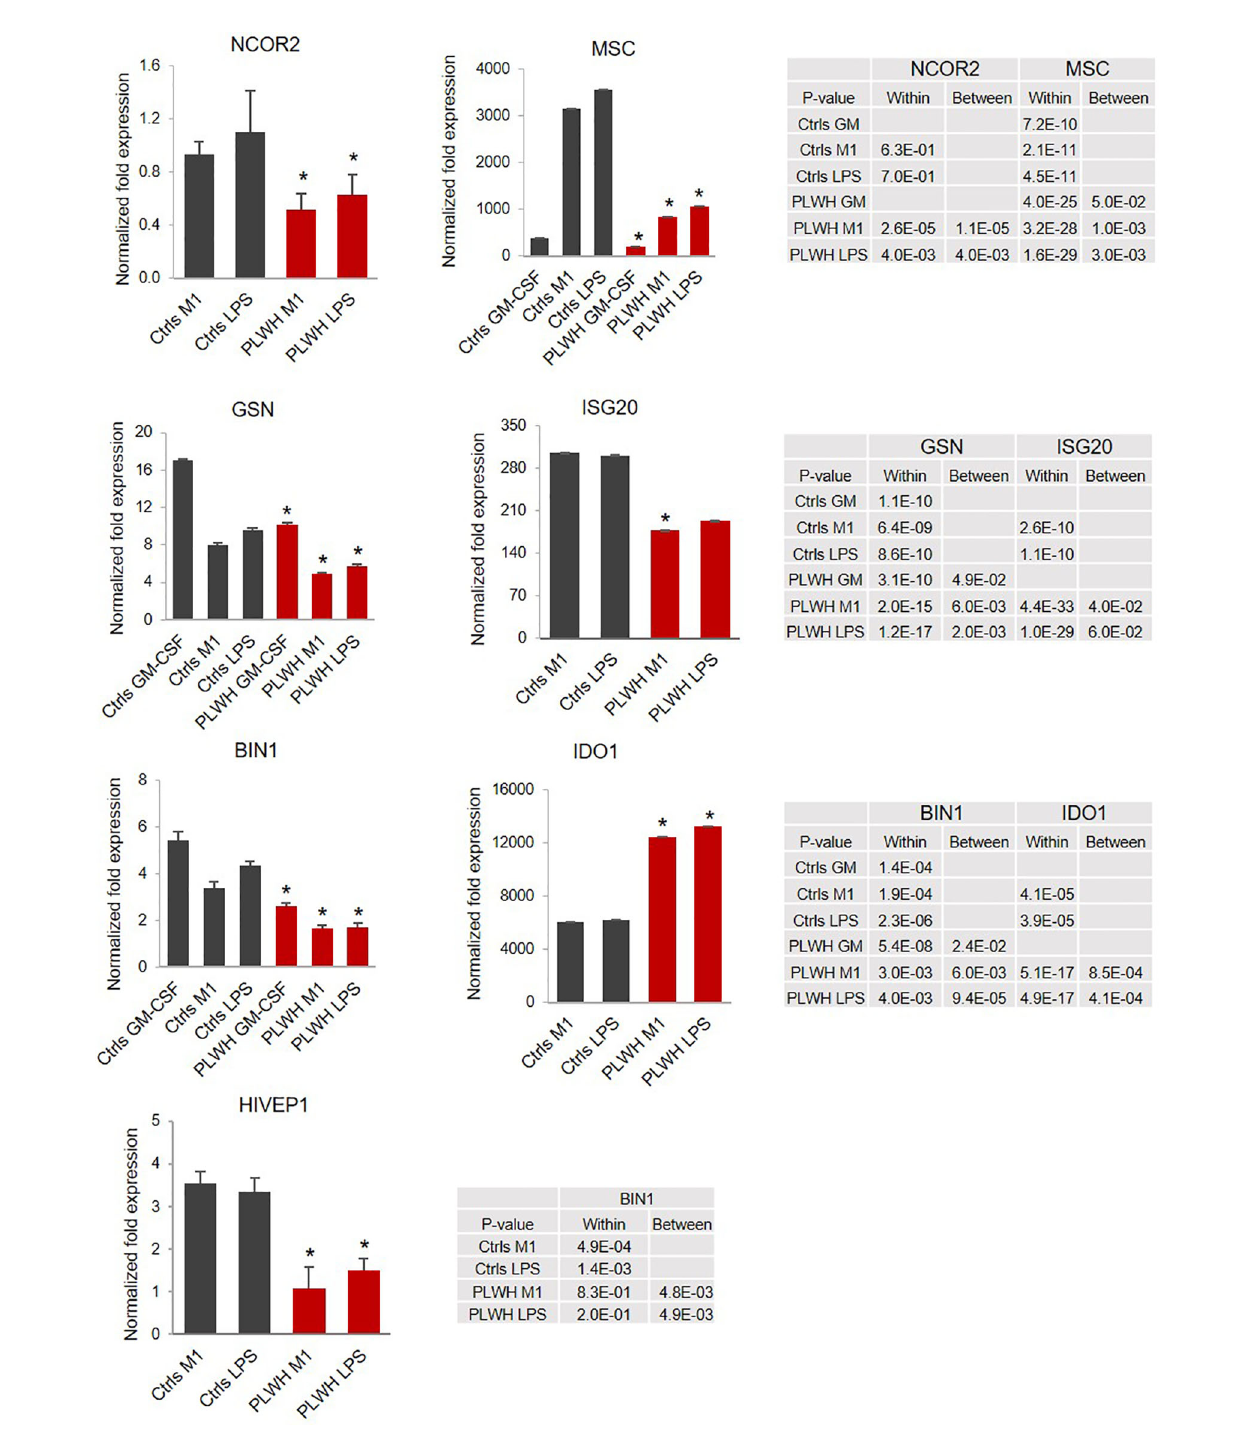
FIGURE 3 | Relative expression of selected genes indicates impaired upregulation of negative regulators of LPS-triggered signaling. Relative expression of the selected mRNAs was calculated over T0 ( GSN , MSC , and BIN1 ) or GM-CSF ( NCOR2 , ISG20 , IDO1 , and HIVEP1 ). The graphs represent the normalized fold change. Error bars indicate SEM; *indicates statistically signi fi cance between groups (Ctrls, n=10; PLWH, n=25). The tables report speci fi c P -values calculated within each group and between